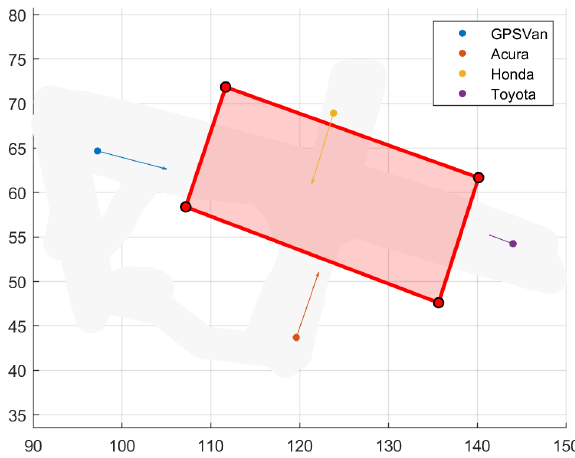
Figure 9. Case study 4: vehicle starting configuration.